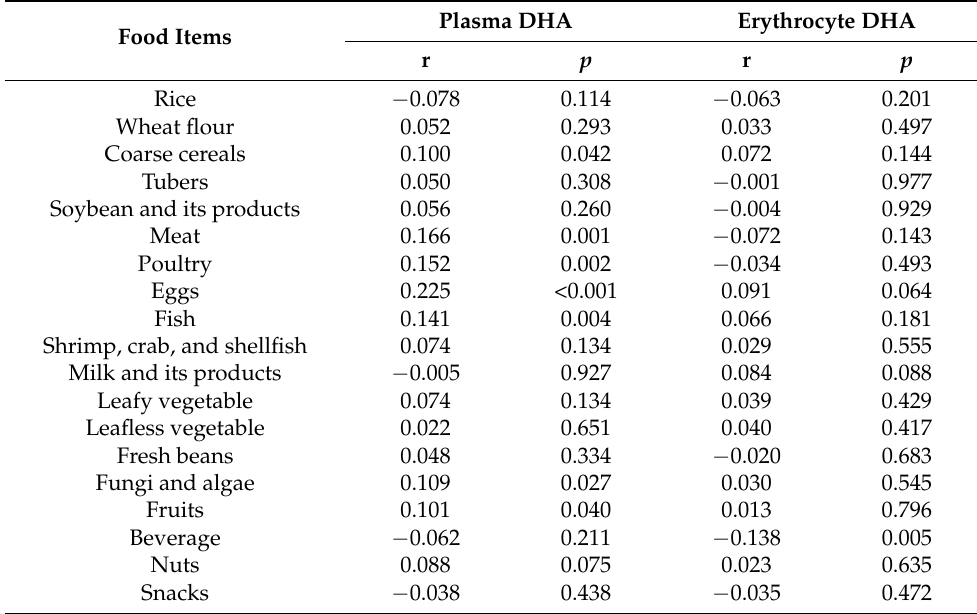
Table 2. The correlation of food items with plasma and erythrocyte DHA status among children.